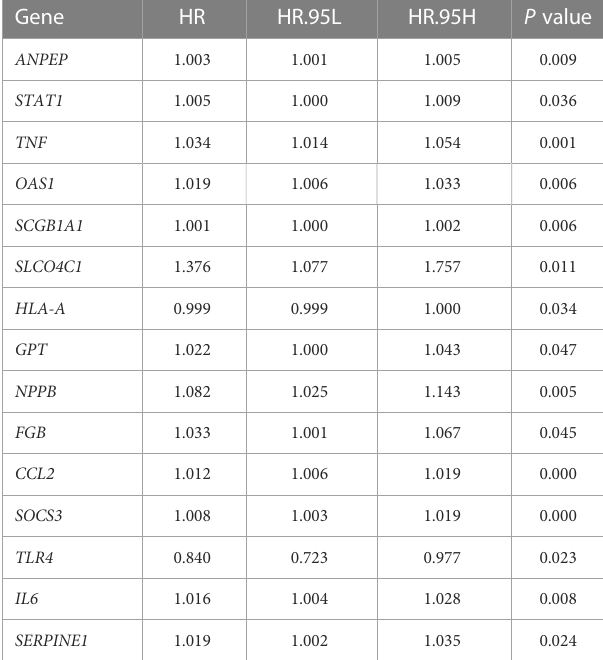
TABLE 2 Signi fi cant genes from univariate Cox regression analysis ( P < 0.05).